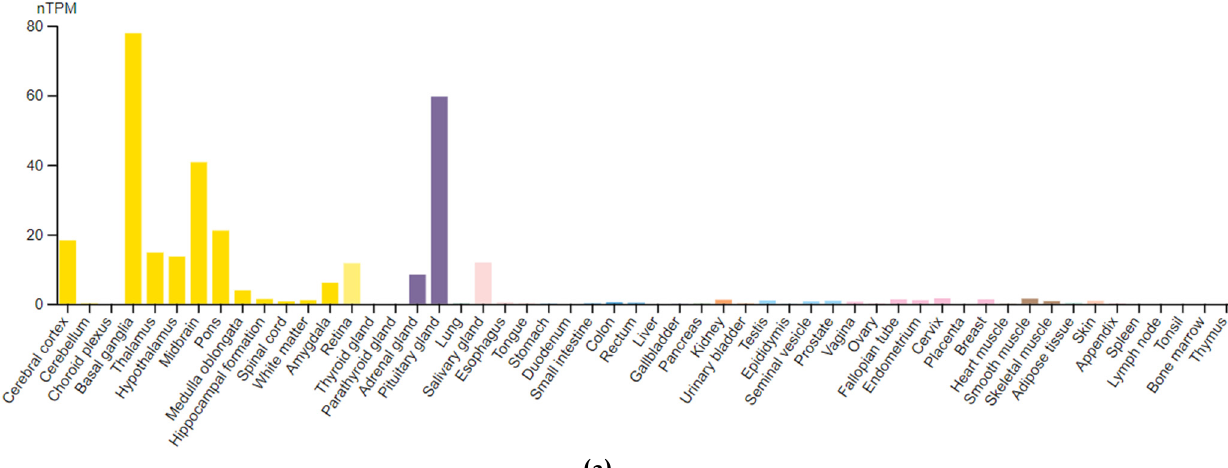
(b) Figure A4. Expression of the DRD2 gene in the human body ( a ) and the brain ( b ) [81].